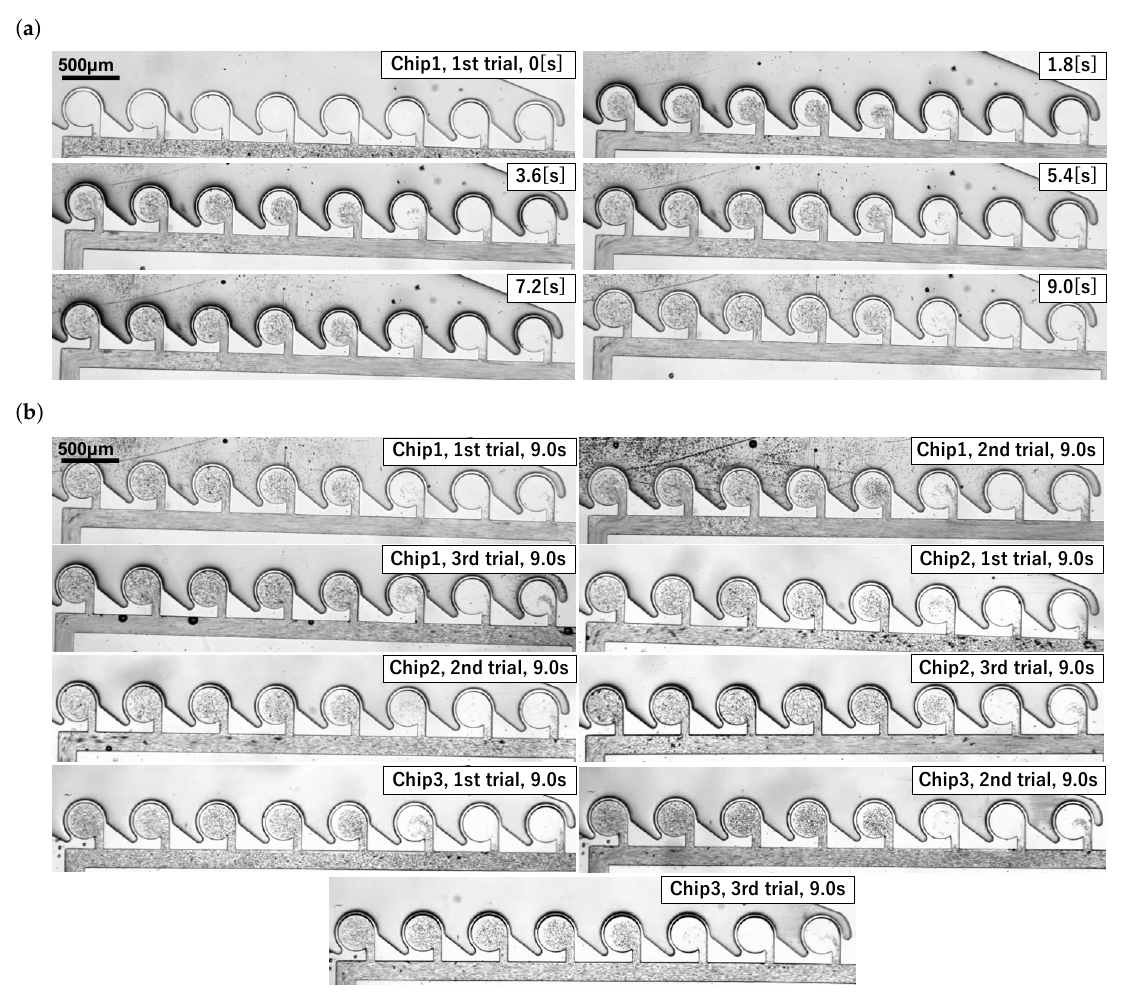
Figure 6. Generation of concentration gradient using an outer-circumference-driven mixer. ( a ) Time variation of an experiment (Chip 1, first trial). ( b ) Experimental results. Similar results were obtained from nine